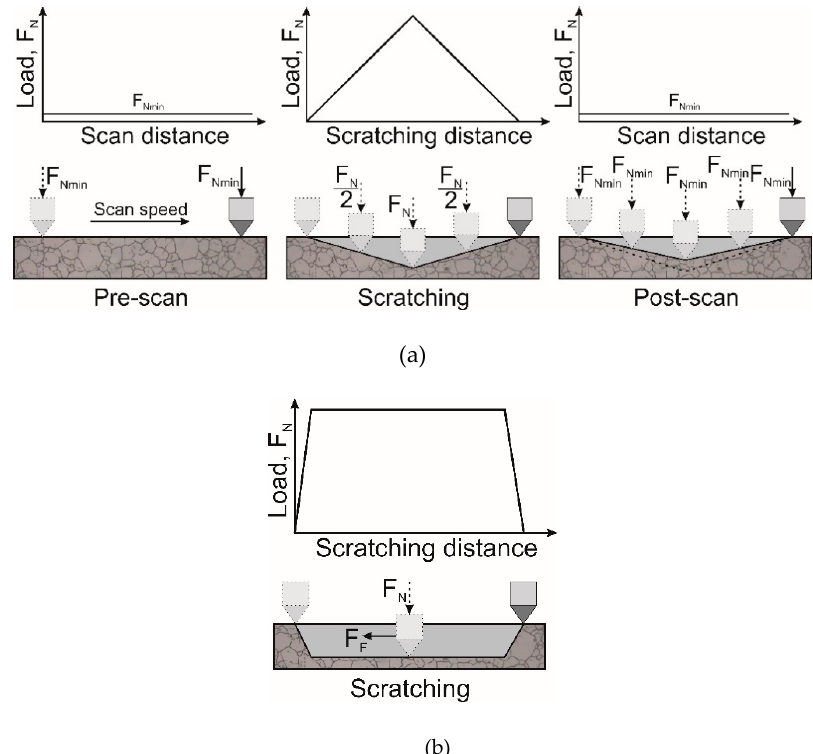
Figure 1. Schemes of progressive ( a ) and static ( b ) specimens scratching.